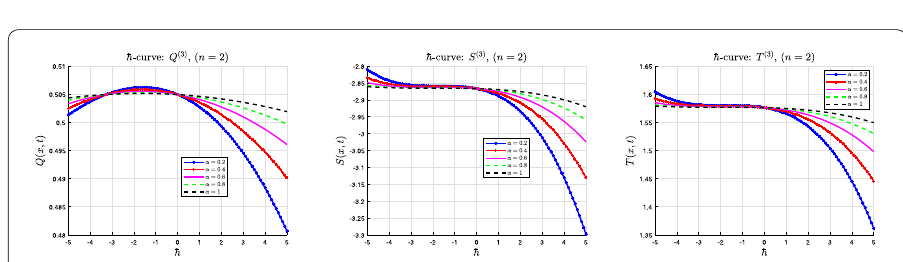
Figure 19 (cid:2) -curves plot with different α when k = η = 0.1, r = –1.5, p = 1.5, x = 10, and t = 0.1 for Example 4.1